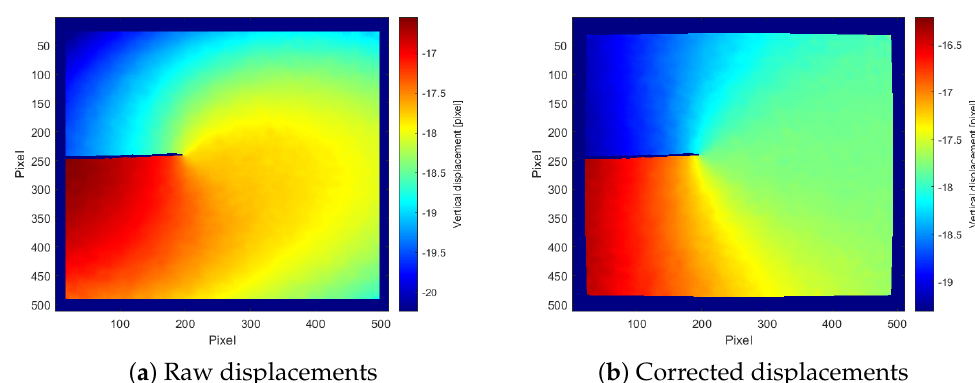
Figure 9. Comparison of raw and corrected